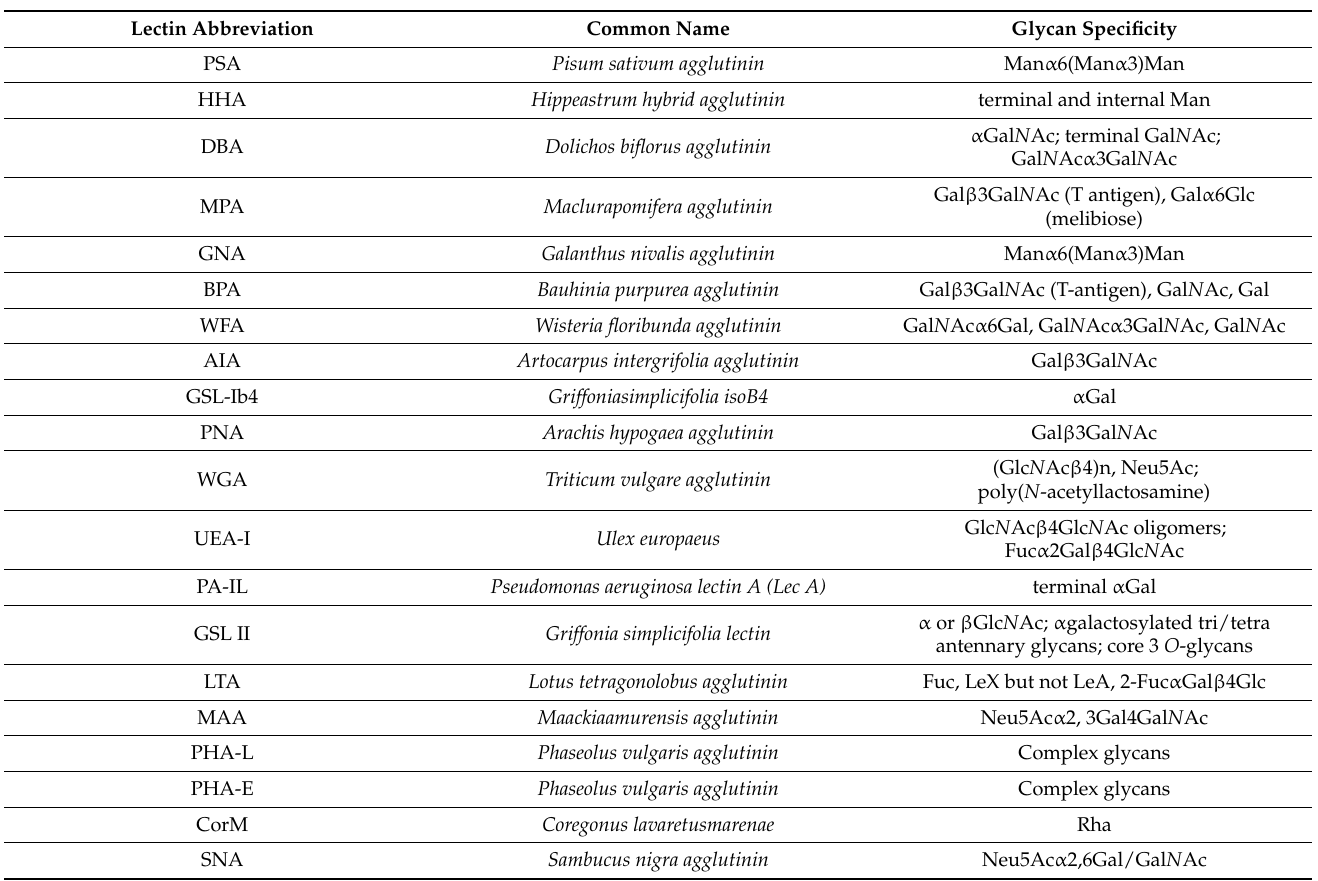
Table 1. Specificity of lectins used for GLYcoPROFILE ® analysis of SARS-CoV-2-positive and - negative nasopharyngeal